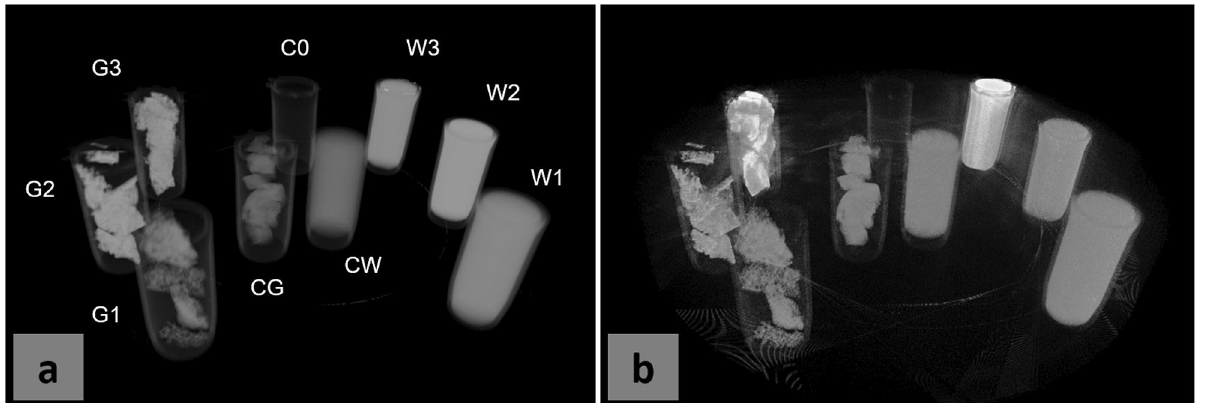
Figure 1. Greyvalue reconstructions obtained with standard absorption CT or DECT, at different contrast agent concentrations. For KBr-doped samples, DECT markedly increases the brightness achieved otherwise. Water-based samples W1: H 2 0 + 2 wt% KI; W2: H 2 0 + 10 wt% KI; W3: H 2 0 + 20 wt% KBr; Glue samples G1: UF + 2 wt% KI; G2: UF + 10 wt% KI; G3: UF + 20 wt% KBr; Control samples C0: empty tube; CW: H 2 0; CG: UF resin. ( a ) standard absorption CT image of a collection of Eppendorf tubes, filled with different solutions, ( b ) DECT image of the same sample collection. Notice how the Bromide-filled tubes stand out in the DECT